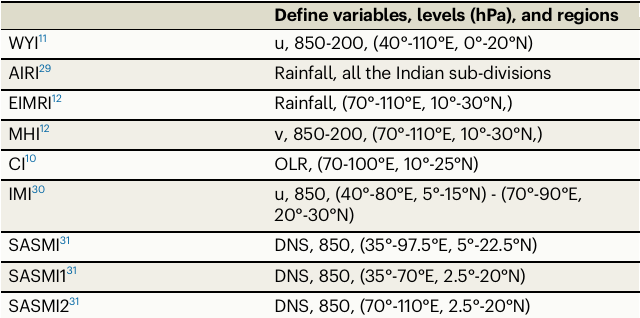
Table 1 | Description of the South Asian summer monsoon indices De fi ne variables, levels (hPa), and